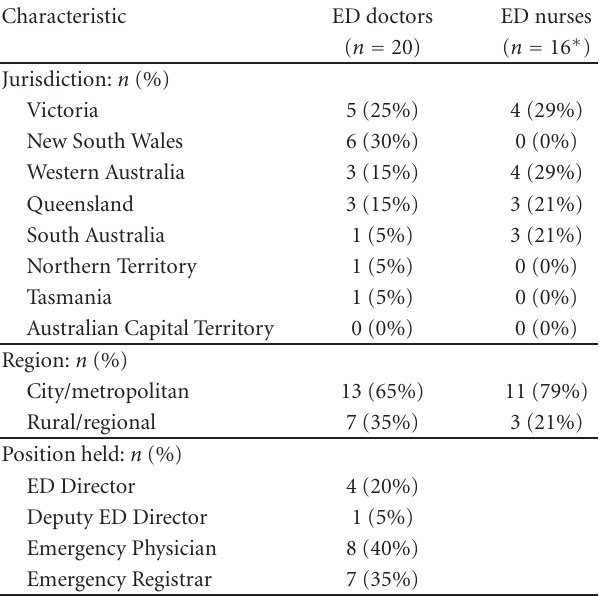
Table 2: Participant